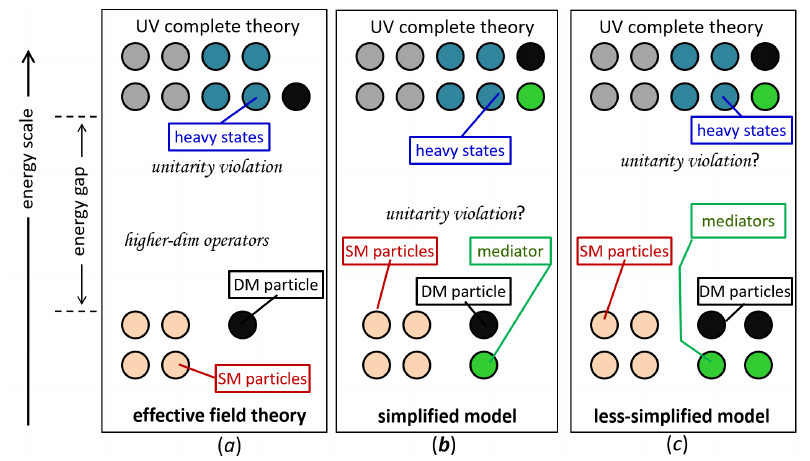
Figure 1 . We compare the three most commonly used frameworks to study dark matter at colliders. These consist of EFTs (left), simplified models (centre) and less-simplified models (right). The pink circles represent the SM particles, the black circles the dark matter particles and the green circles the mediators. At the UV scale, the grey circles are associated with the SM fields without electroweak mixing and the teal circles with the heavy states, whereas the DM particles and the mediators are still represented by black and green circles